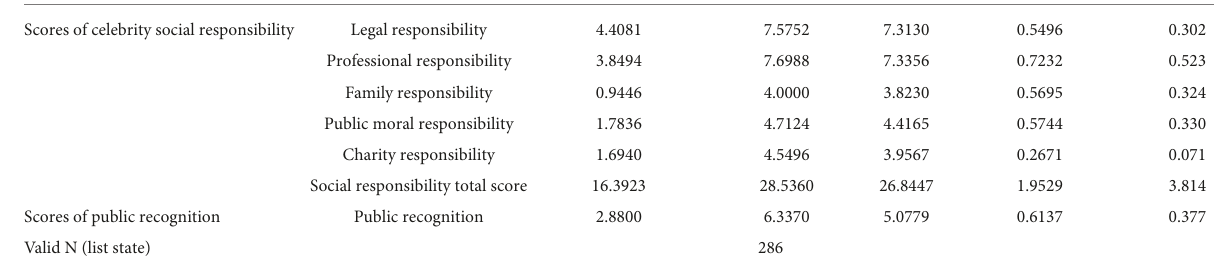
TABLE 2 Descriptive statistical analysis of cinematic celebrities’ social